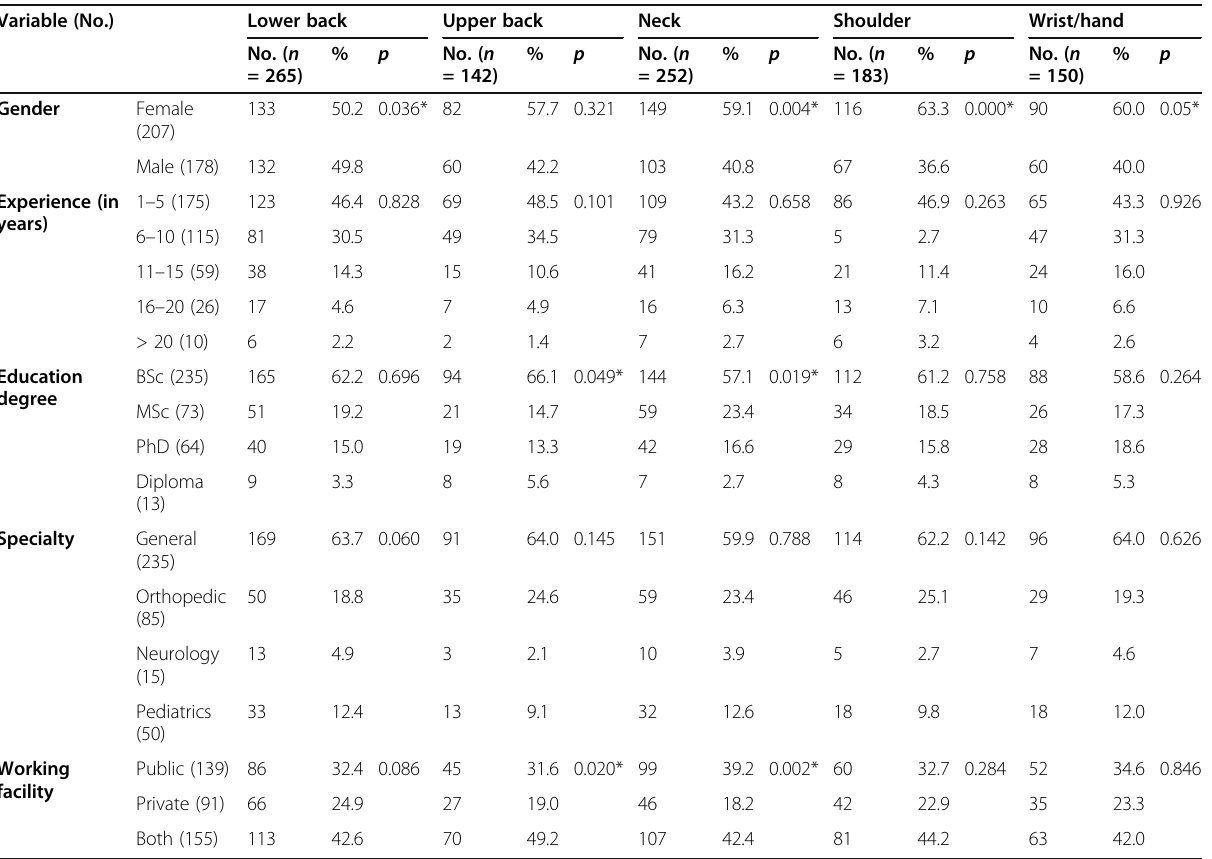
Table 5 Distribution of WRMDs by socio-demographic variables Variable